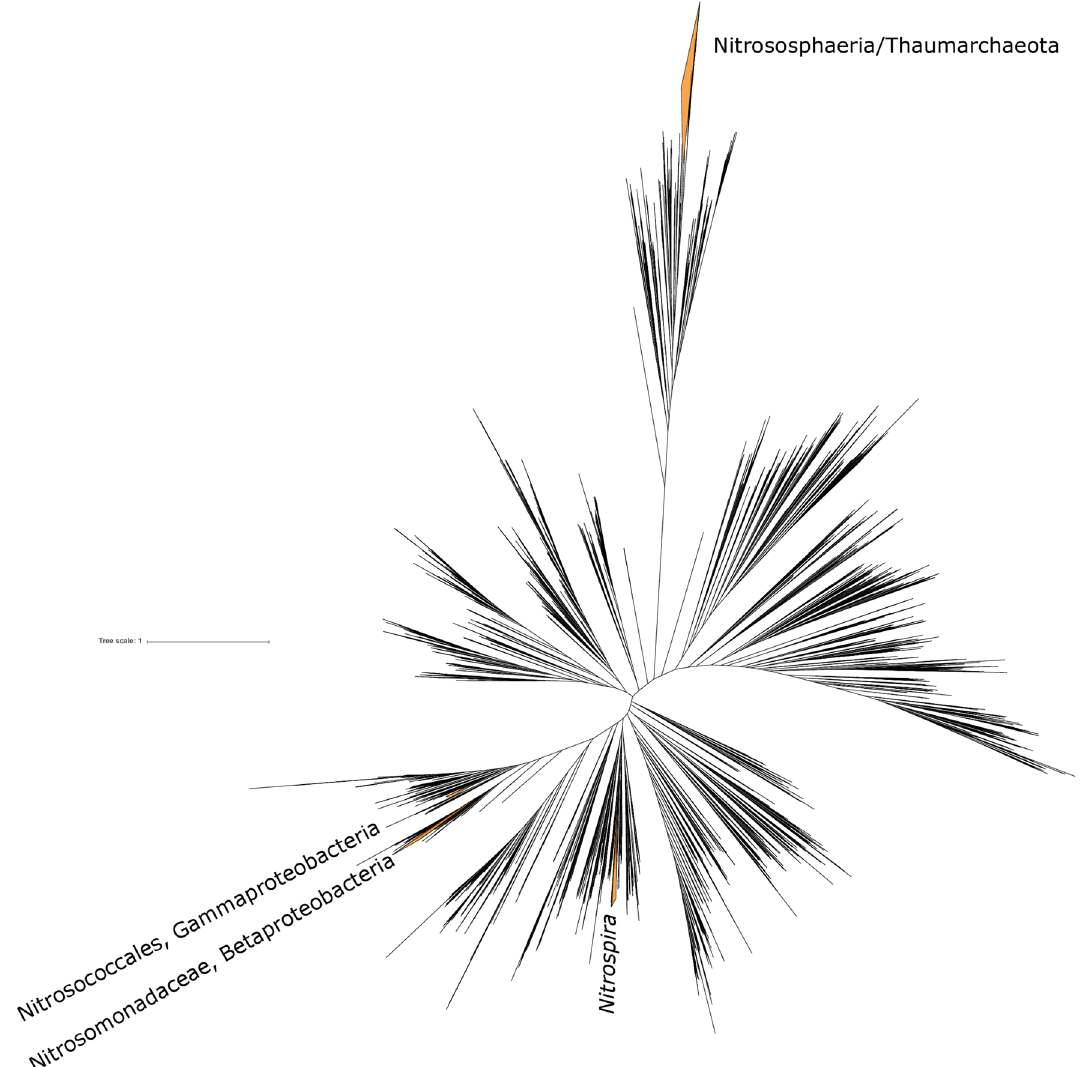
Figure 1. Tree of life built with concatenated ribosomal proteins following methods from 15 . Clades of ammonia oxidizing organisms highlighted in orange and labeled. The distribution of ammonia oxidation is polyphyletic, spread across one lineage within the Archaea (Nitrososphaeria) and three within the Bacteria (Nitrosococcales and Nitrosomonadaceae in the Proteobacteria phylum, and some members of the genus Nitrospira within the Nitrospirota